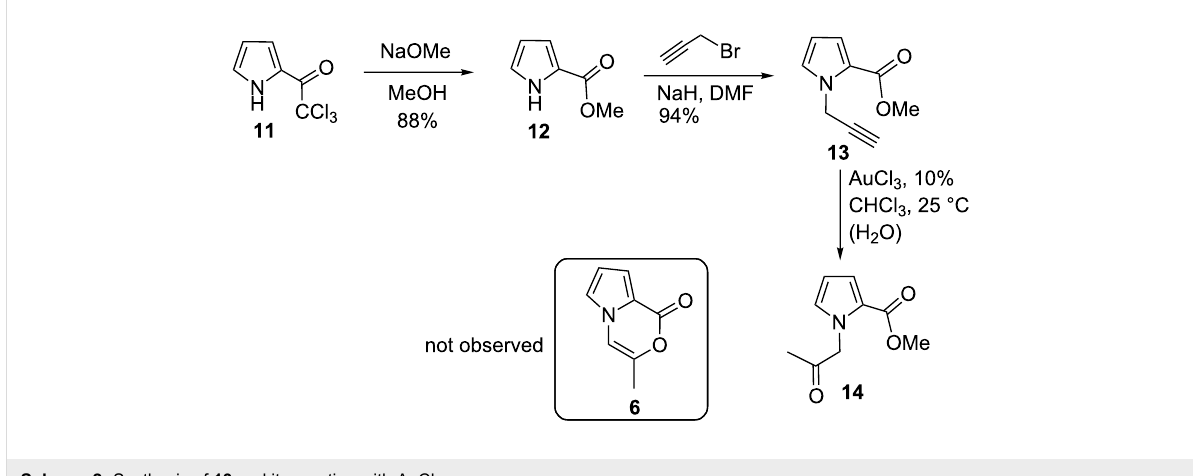
Scheme 2: Synthesis of 13 and its reaction with AuCl 3 .